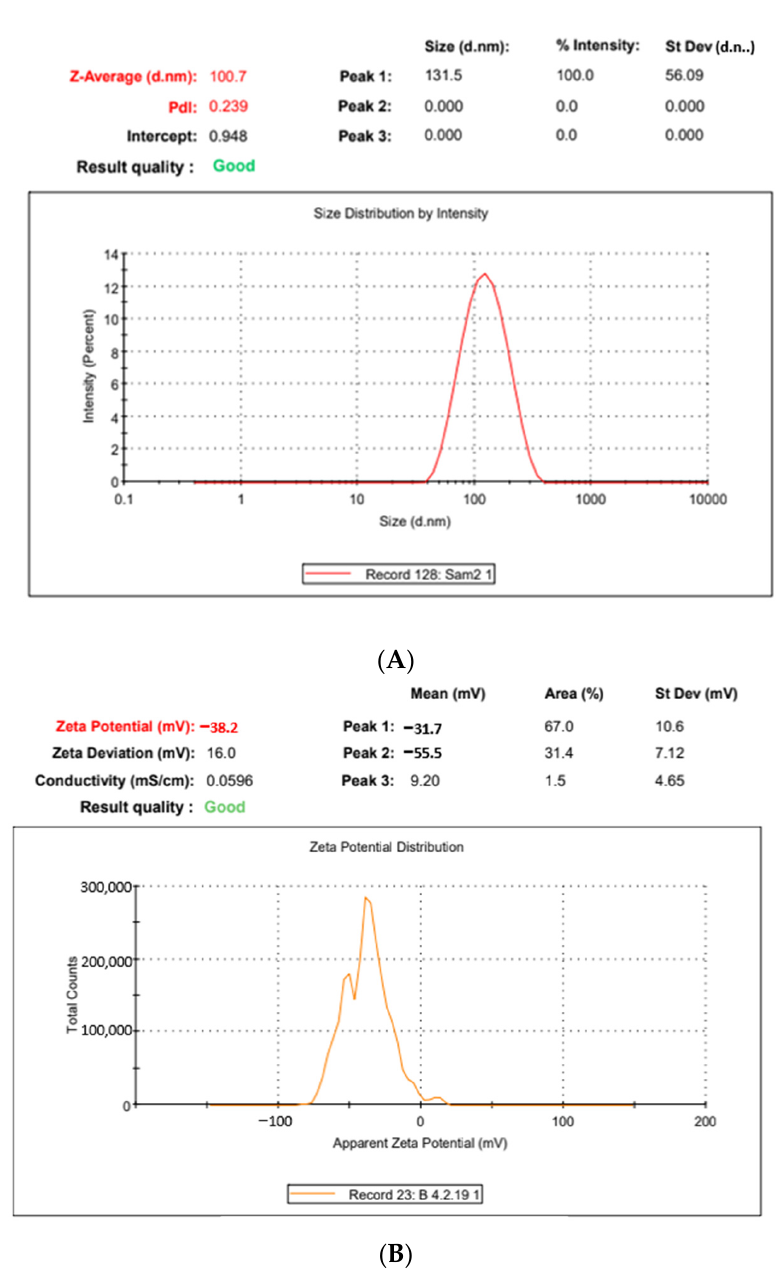
Figure 4. ( A ): The globule size, polydispersity index and globule size distribution of the formulation F8 . ( B ): The zeta-potential graph of the formulation F8 .